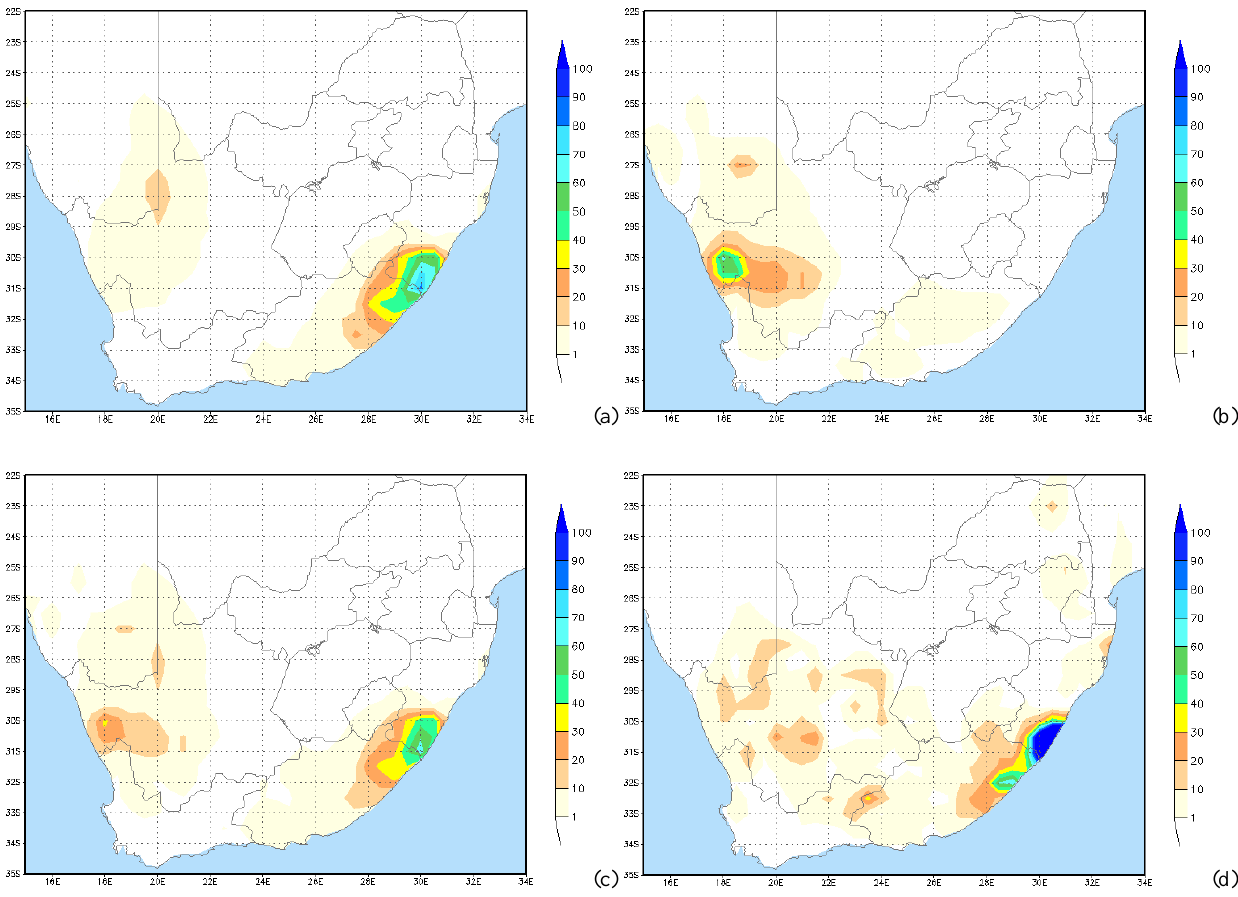
Fig. 13. Unified Model stratiform precipitation total for 24h (a) , Hydroestimator precipitation total for 24h (b) , the combined product from HE and UM for 24h (c) and the total rainfall as measured by the rain gauges (d) for 17 June